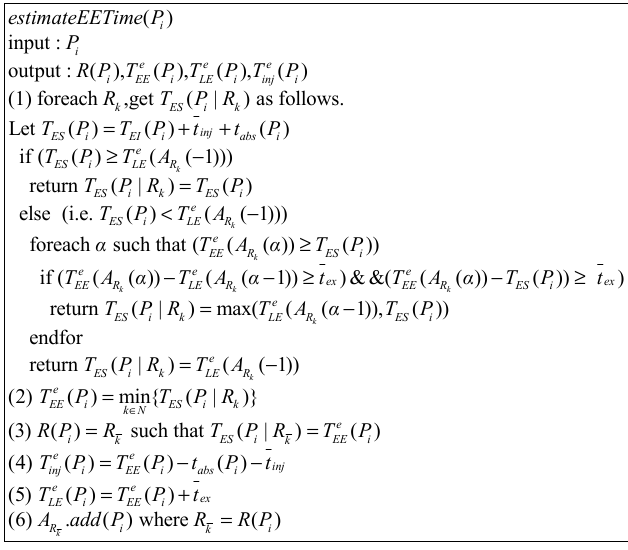
Figure 6. Algorithm for estimating examination process time. Table 2. Weight allocation in the intake room. Bed Type